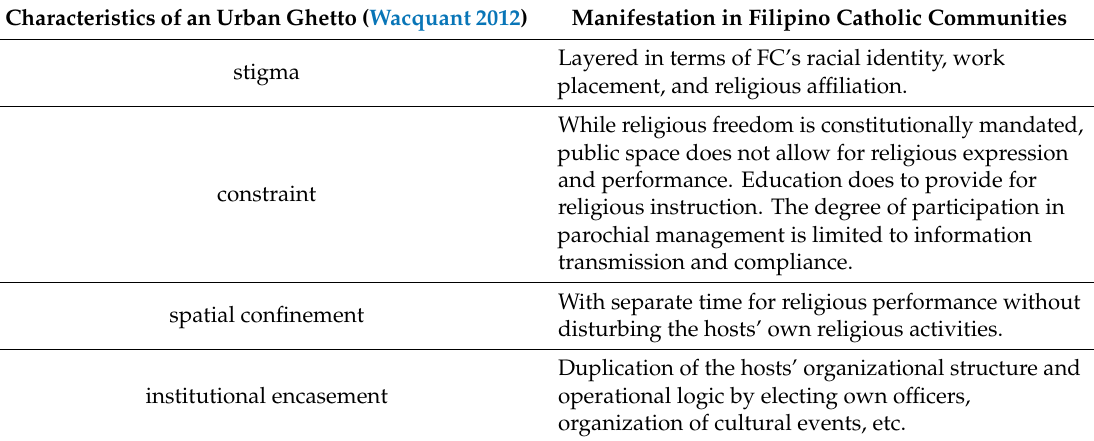
Table 2. Characteristics of urban ghetto and their manifestations in Filipino Catholic communities. Characteristics of an Urban Ghetto (Wacquant